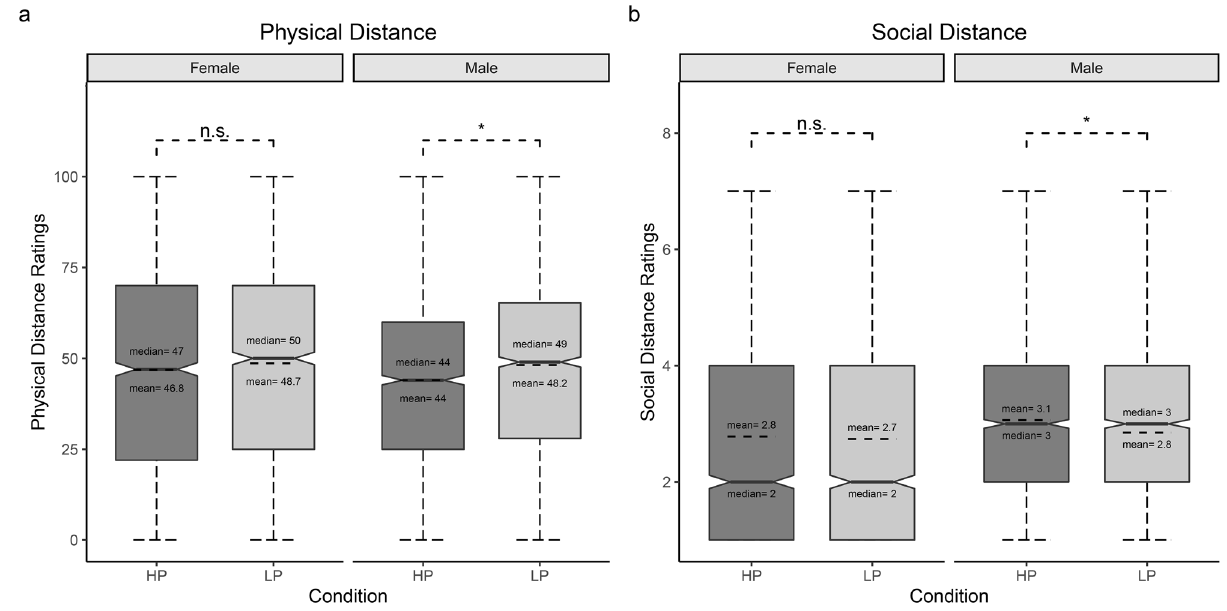
Figure 4. Condition*Gender of Participants interaction. Whisker box plot for ( a ) Physical Distance, and ( b ) Social Distance. Please note that in the latter, only the significant difference between HP and LP is shown for reasons of clarity. * = p <